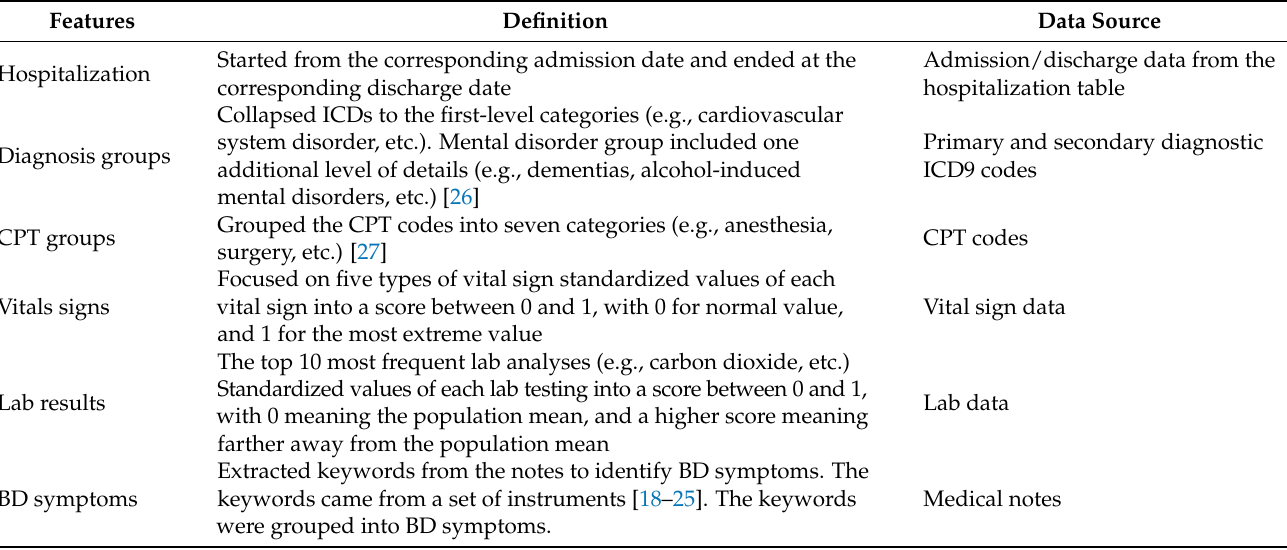
Table 1. Potential features included for outcome prediction, with their definition.